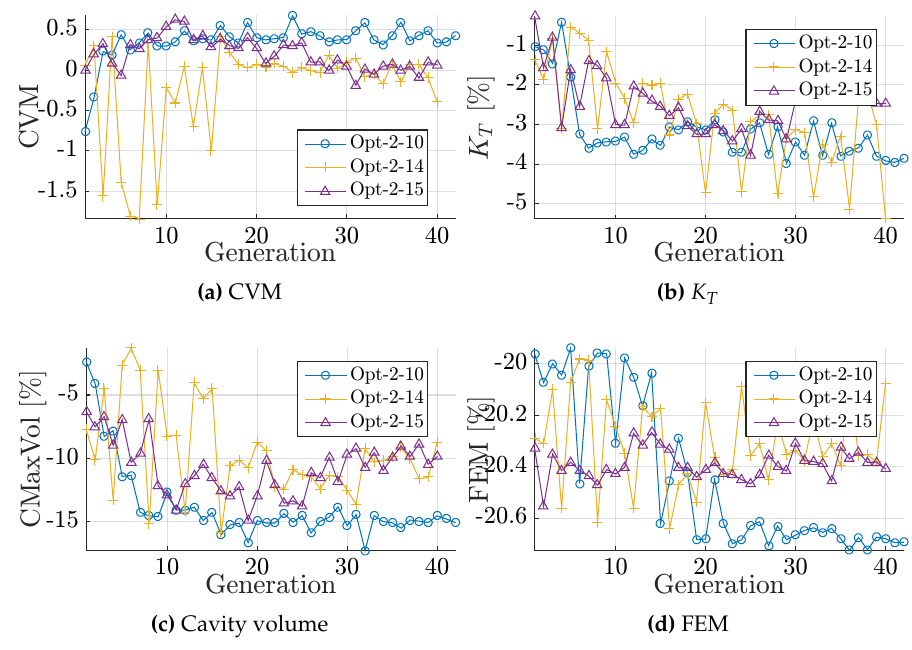
Figure 11. Development of constraints in Group 3. ( a ) CVM; ( b ) K T ; ( c ) Cavity volume; ( d ) FEM.